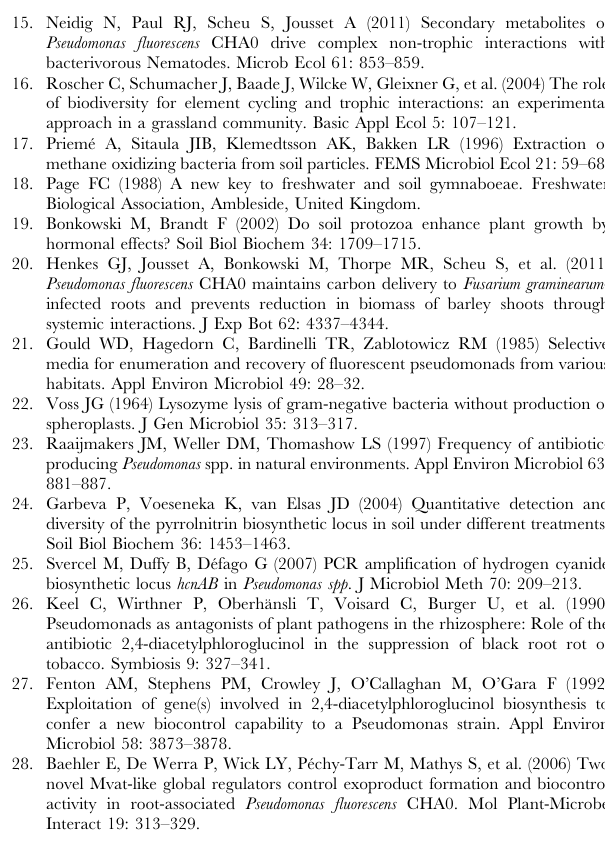
Table S2 Number of sugar beet germ buds (out of the 8 sown in each microcosm) with infection symptoms in the biocontrol assay.